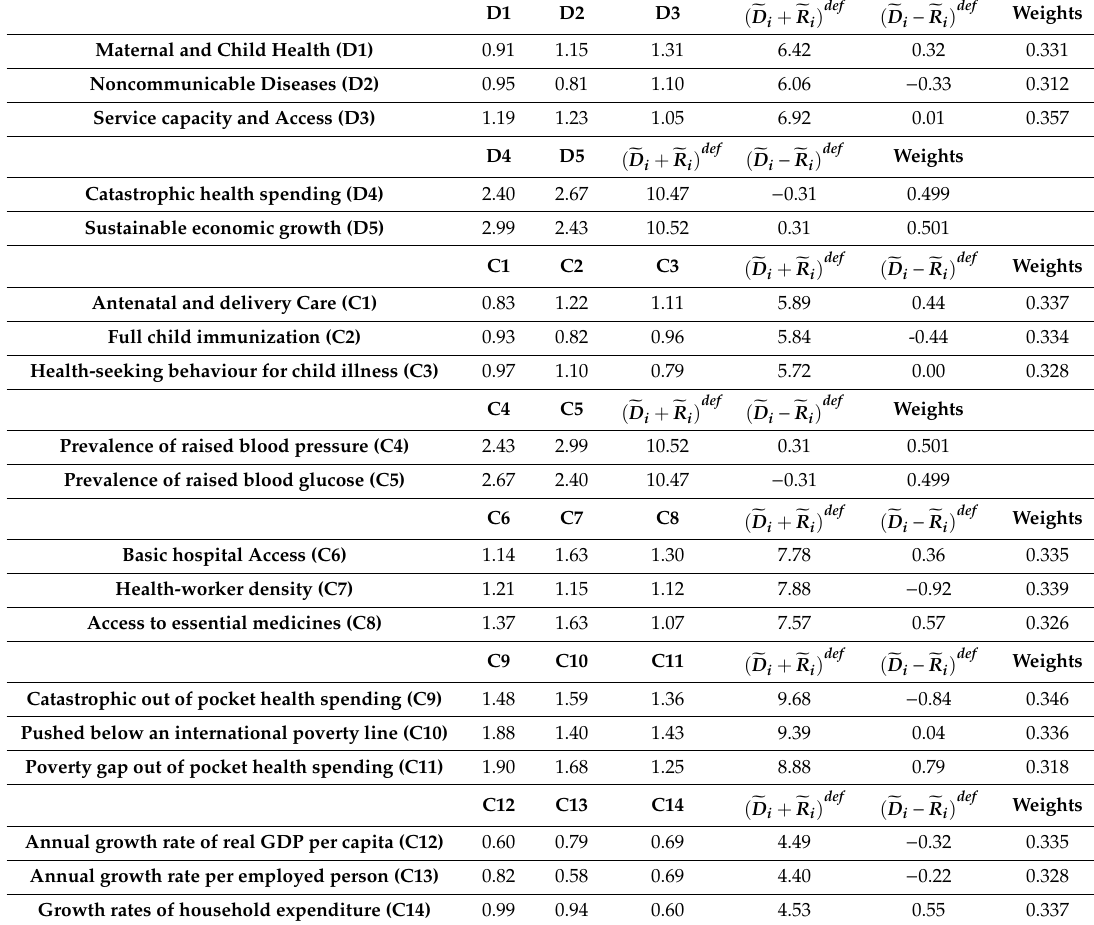
Table A4. Defuzzified total relation matrices and